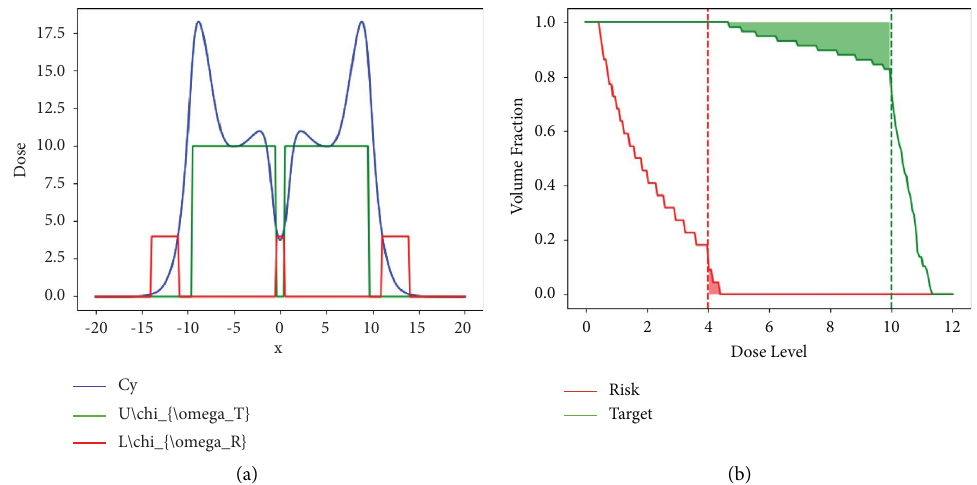
Figure 5: Dose information for dose-constrained equation (3) with 􏽥 β (b) Dose volume histogram for risk w R and target region w T